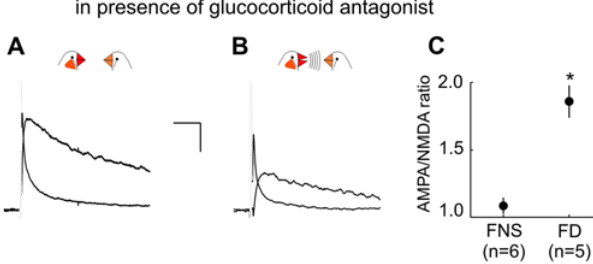
Figure 3. Inhibition of glucocorticoid receptor activation does not block increase of AMPA/NMDA ratio after exposure to female without singing. (A, B) Representative plots of average EPSCs mediated by AMPA and NMDA glutamate receptors onto VTA dopaminergic neurons after not singing (A) and singing (B) in the presence of a female, in males treated with mifepristone. Scale bar indicates 50 msec, 40 pA. (C) Average AMPA/NMDA ratios recorded from males treated with mifepristone after exposure to a female and not singing (FNS, n=6 recorded from 5 birds) or singing (FD, n=5 recorded from 5 birds; asterisk indicates p , 0.001, t-test).